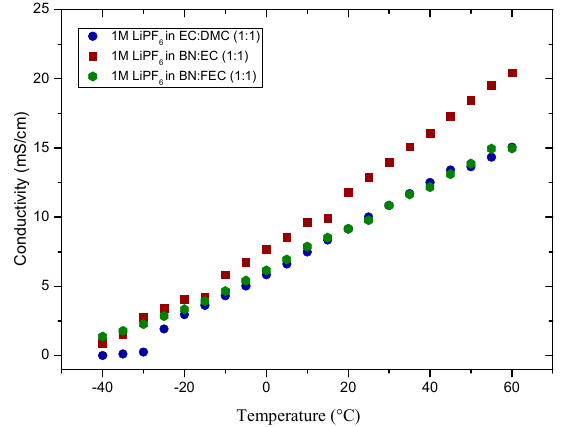
Figure 1. Temperature dependent conductivity measurements of 1M LiPF 6 in EC:DMC (1:1), 1M LiPF 6 in BN:FEC (1:1) and 1M LiPF 6 in BN:EC (1:1), in the temperature range from − 40 to 60 °C.